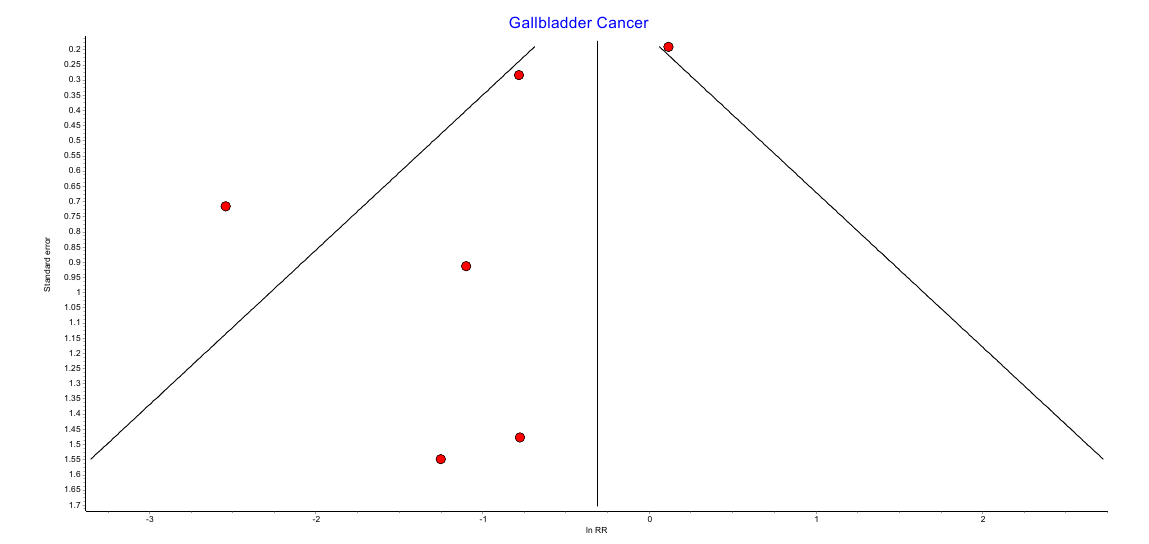
Figure A15. Gallbladder cancer random effects model funnel plot.